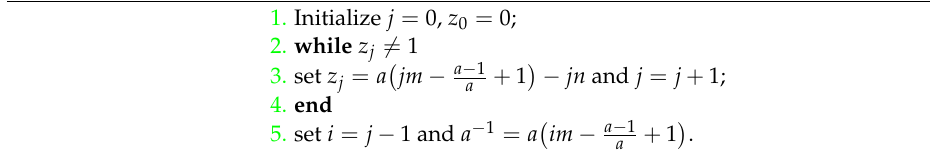
Algorithm 1 Pseudocode of the algorithm for solving